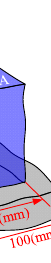
Table 1. Assembly states of the assembly with three mating planes.